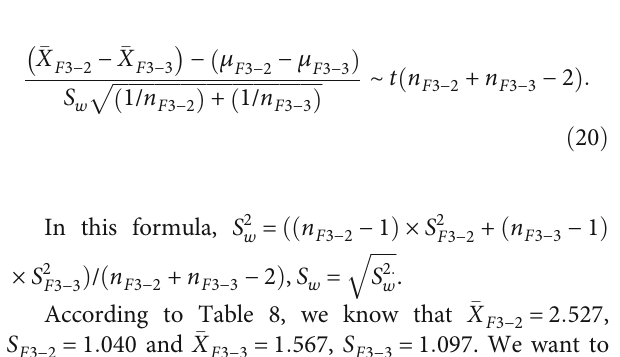
(cid:1) X = 2 : 527 , According to Table 8, we know that F 3 − 2 S = 1 : 040 and (cid:1) X = 1 : 567 , S = 1 : 097 . We want to F 3 − 2 F 3 − 3 F 3 − 3 verify the con fi dence interval with a con fi dence level of 0.95 for the two population mean di ff erence μ F 3 − 2 − μ F 3 − 3 . We